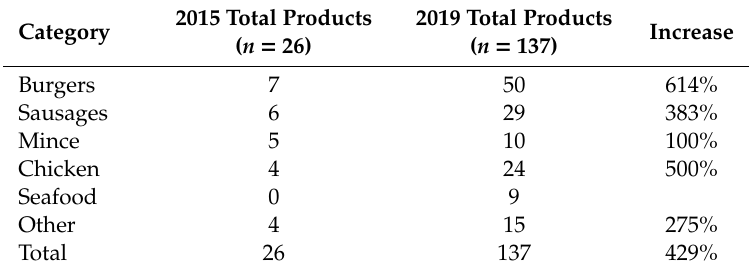
Table 2. Changes in product numbers and type of plant-based meat substitute product between 2015 and 2019